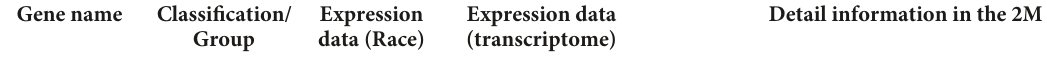
TABLE 2 The information about MHC-I genes in Chinese